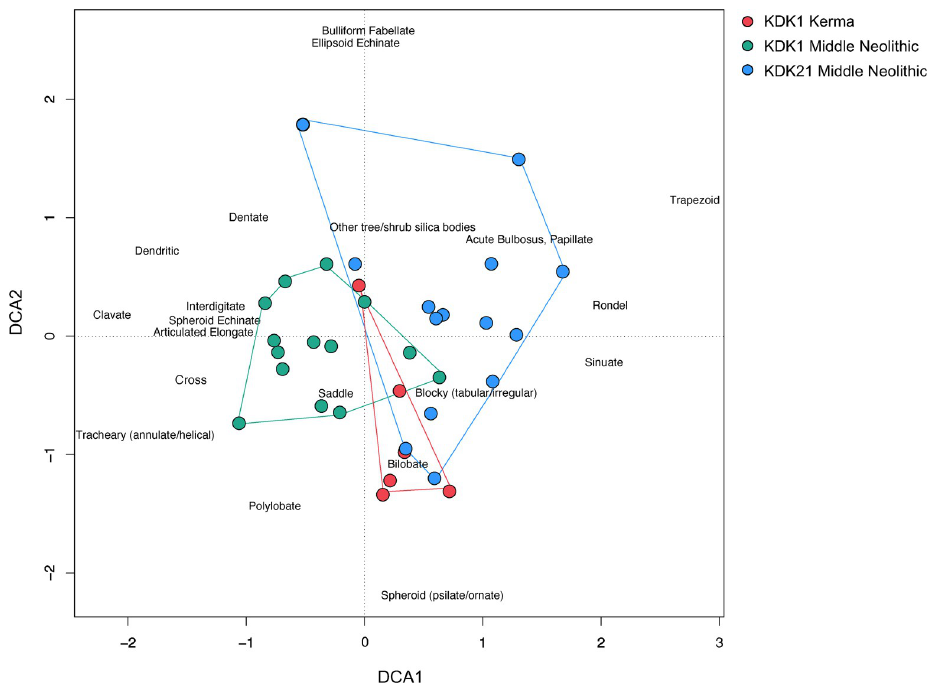
Fig 9. Detrended correspondence analysis (DCA) scatterplot of phytolith morphotype presence/absence data from dental calculus samples according to archaeological group. DCA scatterplot displaying 28.04% of the variance within the sample data, primary variation in the data is represented along axis 1, while secondary variation is represented along axis 2. The eigenvalues of axes 1 and 2 are 0.3280 and 0.2537, respectively. The total inertia is 2.075.